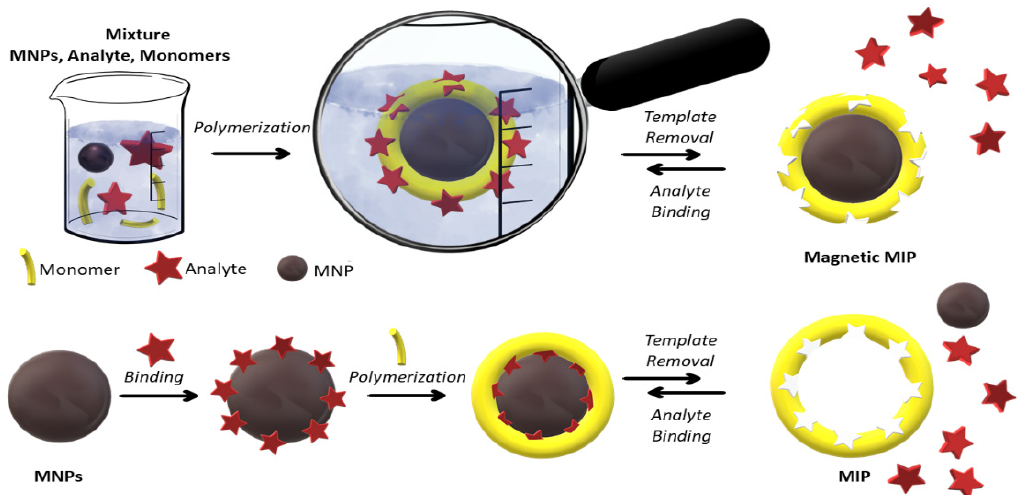
Figure 12. Schematic representation of core–shell imprinting for MMIP preparation. The analyte is a template molecule that MIP has reversibly recognized. The number of cycles is proportional to the efficiency of